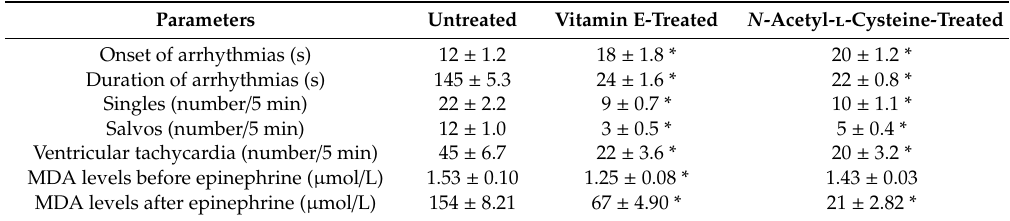
Table 3. Modification of various types of arrhythmias and plasma malondialdehyde (MDA) levels due to epinephrine (32 µ g / kg) in rats with and without vitamin E (20 mg / kg / day) or N -acetyl- l -cysteine (200 mg / kg / day) treatment for 21 days.